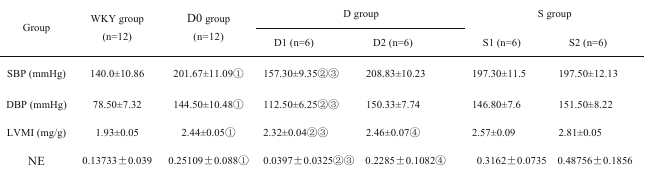
TABLE 1 - SBP, DBP and LVMI in different groups ( sx ±